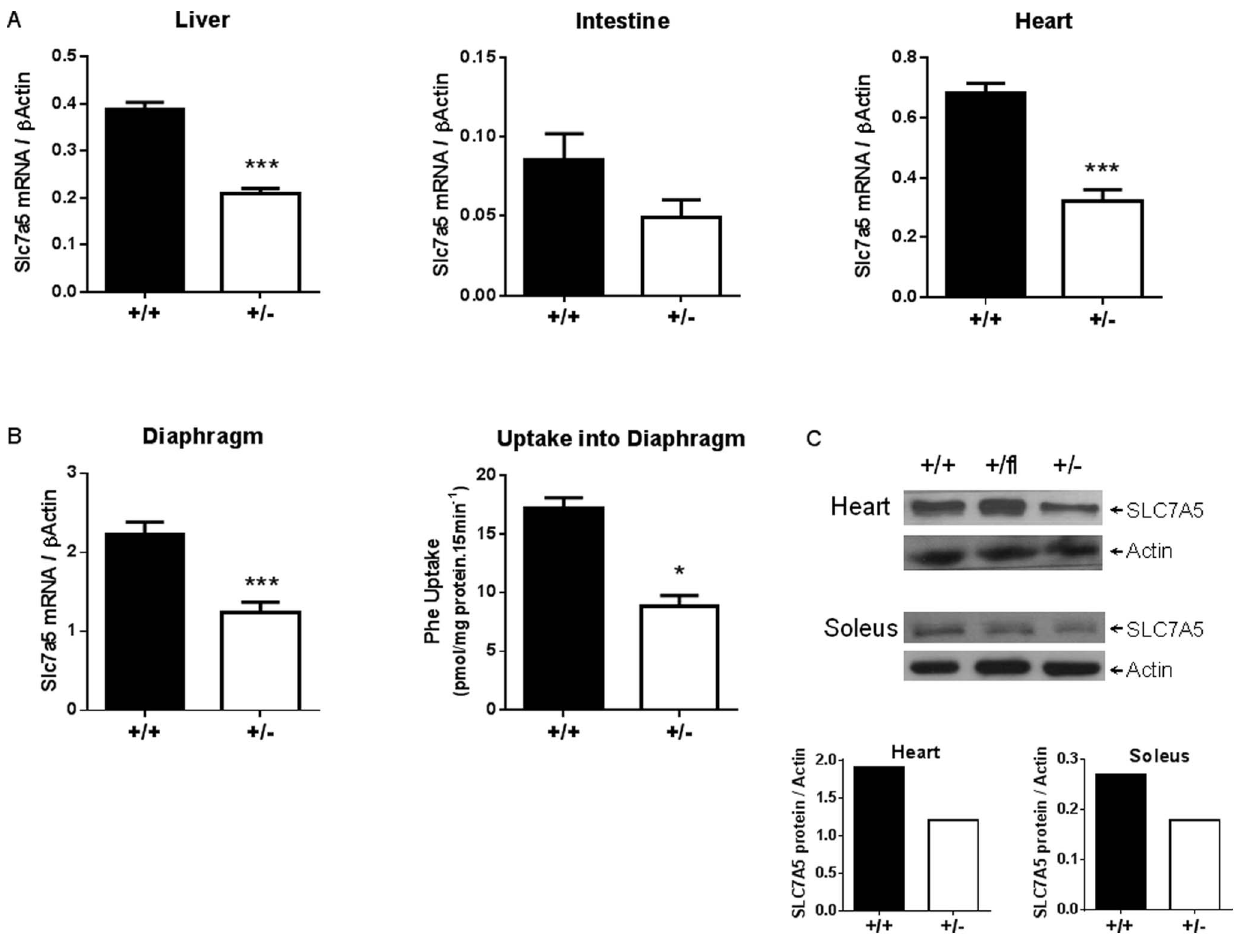
Figure 2. Both Slc7a5 gene expression and SLC7A5 transport activity are reduced in Slc7a5 + / 2 mouse tissues. (A) Slc7a5 mRNA expression in liver, heart and intestine (as indicated) from Elalpha -Cre Slc7a5 + / + (n=5–9) and Slc7a5 + / 2 (n=4–5) mice as determined by qPCR and normalized to b -Actin. Intestine was determined not significant (N.S.) although p , 0.1. (B) Slc7a5 mRNA expression in diaphragm from Slc7a5 + / + and Slc7a5 + / 2 mice as determined by qPCR and normalized to b -Actin (n=6). Uptake of 3 H-phenylalanine into diaphragm from Slc7a5 + / + and Slc7a5 + / 2 mice (n=5). *and ***indicate p , 0.05 and p , 0.001 respectively by unpaired t-test. (C) Representative Western blot of SLC7A5 protein in heart and soleus muscle lysates from from Slc7a5 + / + and Slc7a5 + / 2 mice. Blot quantitation shown in lower